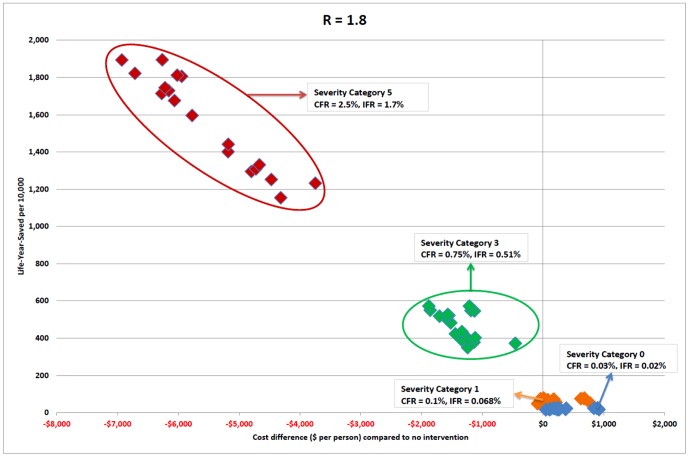
Intervention strategy cost effectiveness plane for severity categories 0, 1, 3 and 5 with death related productivity losses.Cost effectiveness for each intervention strategy is plotted as a point in a two-dimensional plane, with points coloured by severity category: blue points - category 0 (case fatality ratio 0.03%), orange points - category 1 (case fatality ratio 0.1%), green points - category 3 (case fatality ratio 0.75%), red points - category 5 (case fatality ratio 2.5%). Horizontal axis represents the cost of the intervention strategy as a difference in total cost between two scenarios; an outbreak with the intervention in place and an outbreak with no interventions, expressed as dollars per member of the population. Vertical axis represents the number of life years saved by each strategy: the difference in life years lost for an outbreak with and without the strategy in place, expressed as life years saved per 10,000 population members. Both costs (death related productivity losses) and LYS are discounted.